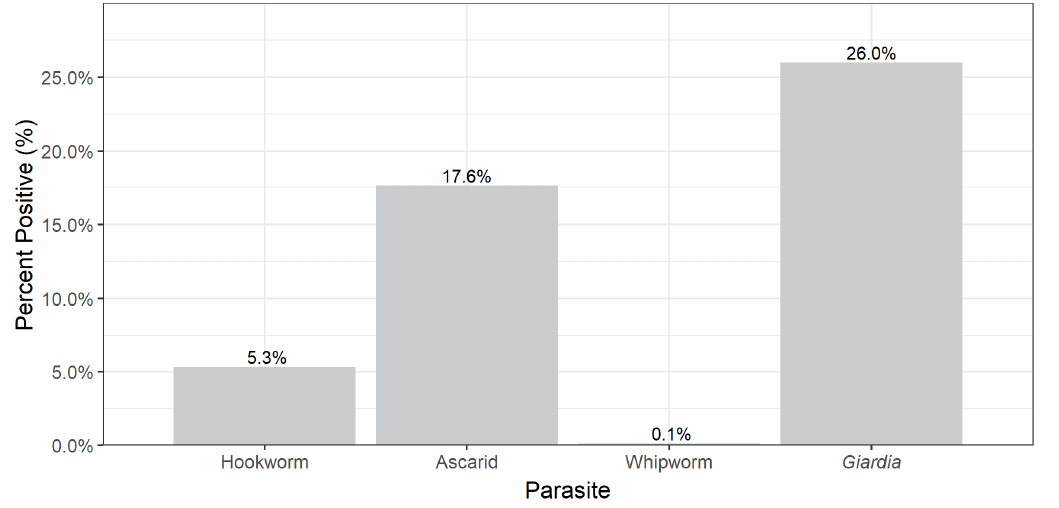
Figure 1. Prevalence of parasites detected in dogs.